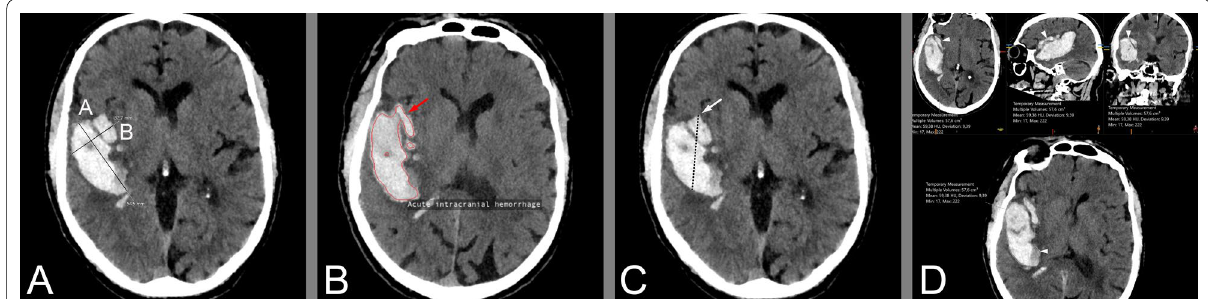
Fig. 6 Volumetric methodology. Panel A illustrates the principle of the ABC/2 method where A is the largest diameter of the hematoma in axial images, B is the largest perpendicular diameter, and C is the number of slices with hematoma visible multiplied with the slice distance. Panel B illustrates the measurement done by the automated hematoma segmentation tool qER-qQuant from Qure.ai. Panel C and D illustrate the semi-automated measurement done in Sectra IDS7 where an arbitrary diameter is drawn through the hematoma (panel C ) and the software then identifies the boundaries and calculate the volume (panel D